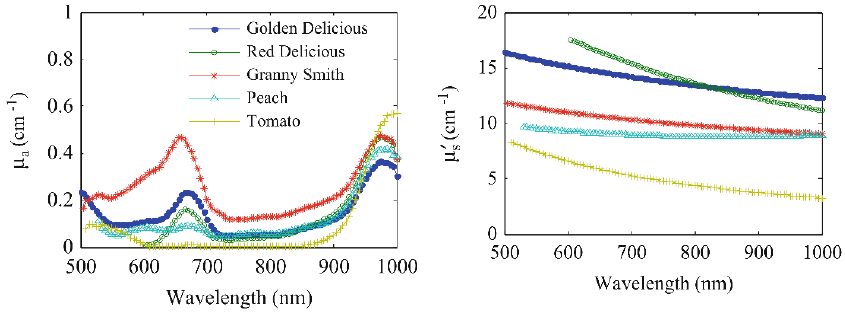
Figure 23. Absorption ( left ) and reduced scattering coefficient ( right ) spectra for apple, peach and tomato samples. Reproduced with permission from [92], Copyright Springer, 2015.